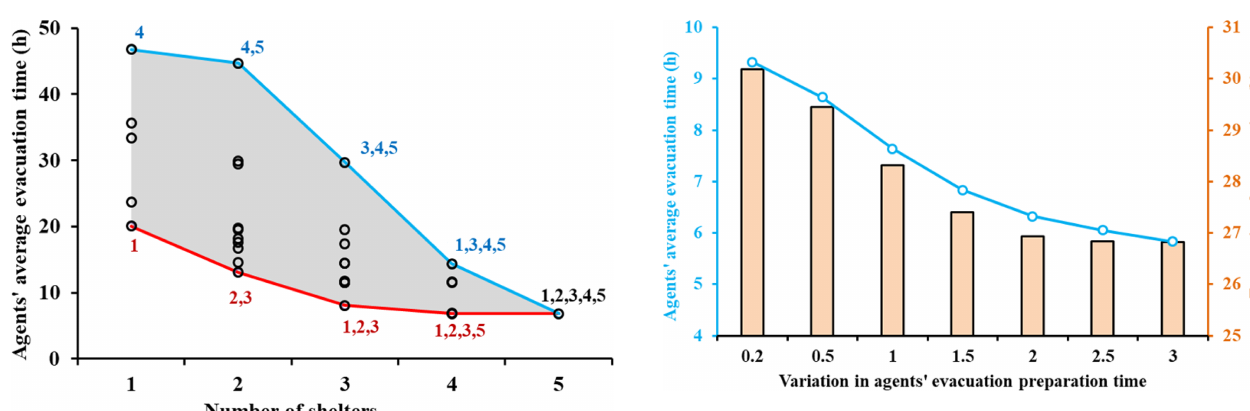
Figure 10. The impacts of human behavioral heterogeneity (i.e., the variation in agents’ evacuation preparation times) on their average evacuation time (left y axis) and the system-level evacuation clear- ance time (right y